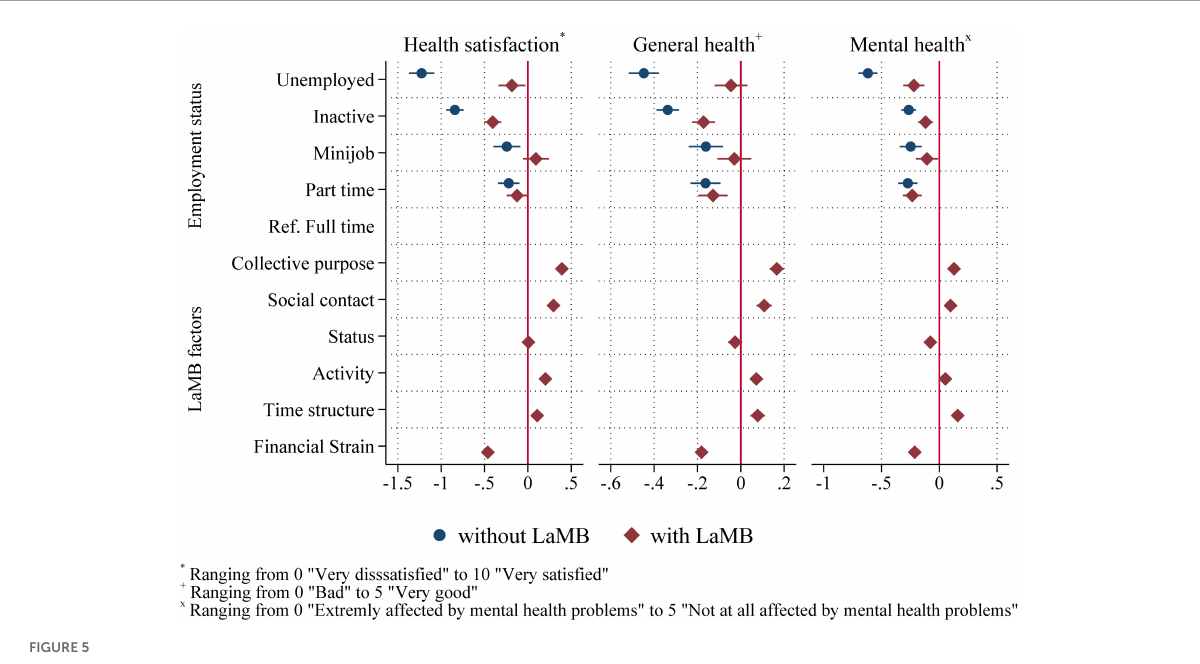
FIGURE5 Coefficient plot from regressions of well-being measures on employment status and LaMB factors (net of the effects of age, age squared, gender, education, partner in HH, child (under 15) in HH, and interview mode). 95% CI. Both outcome scales range from 0 “completely dissatisfied” to 10 “completely satisfied.” The results correspond to columns 1 to 4 in Supplementary Appendix Table A9